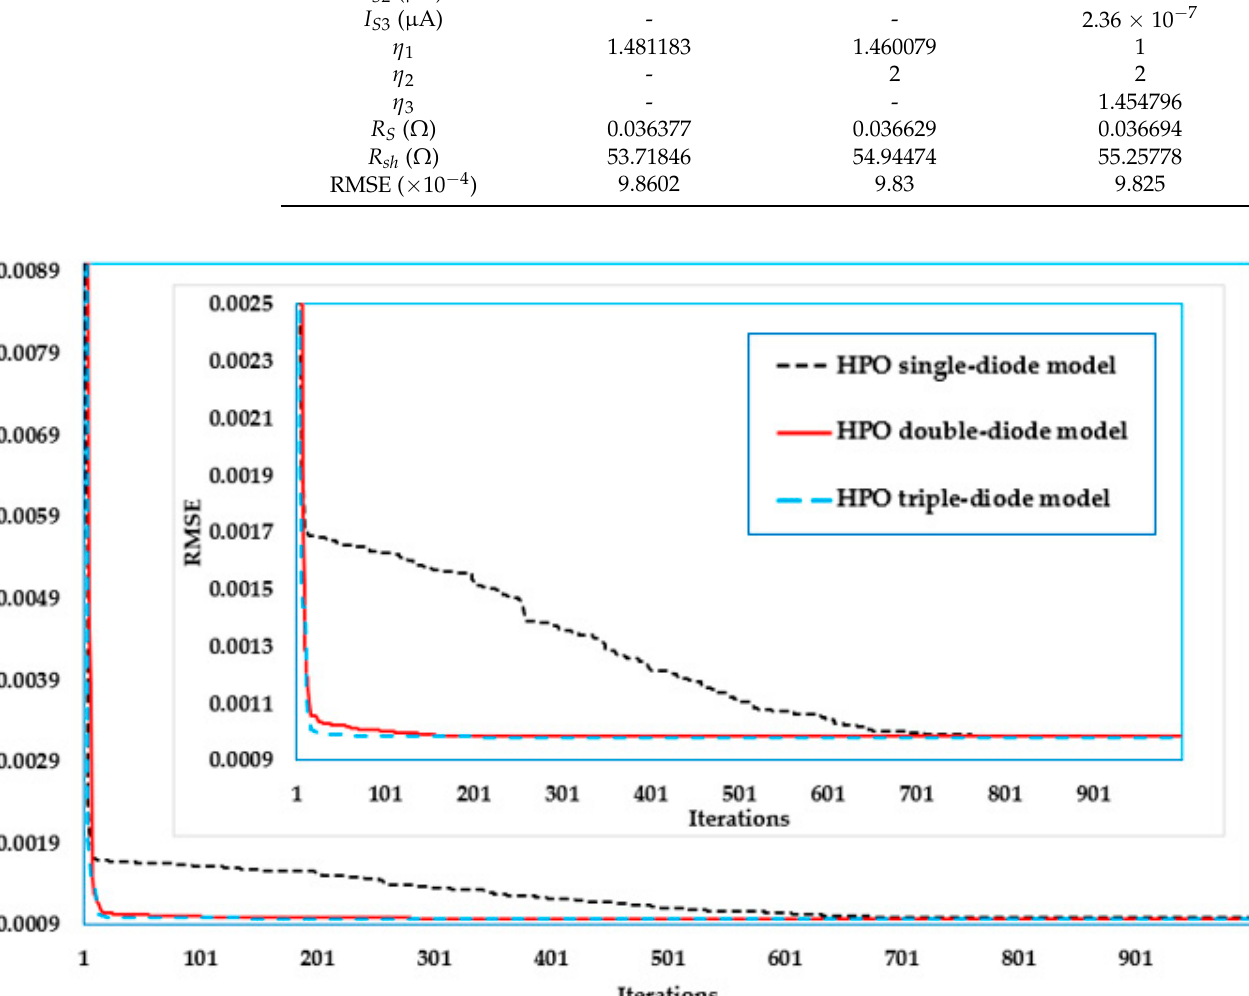
Figure 12. Convergence trends of the proposed HPO technique for the three diode models of RTC France PV cell.